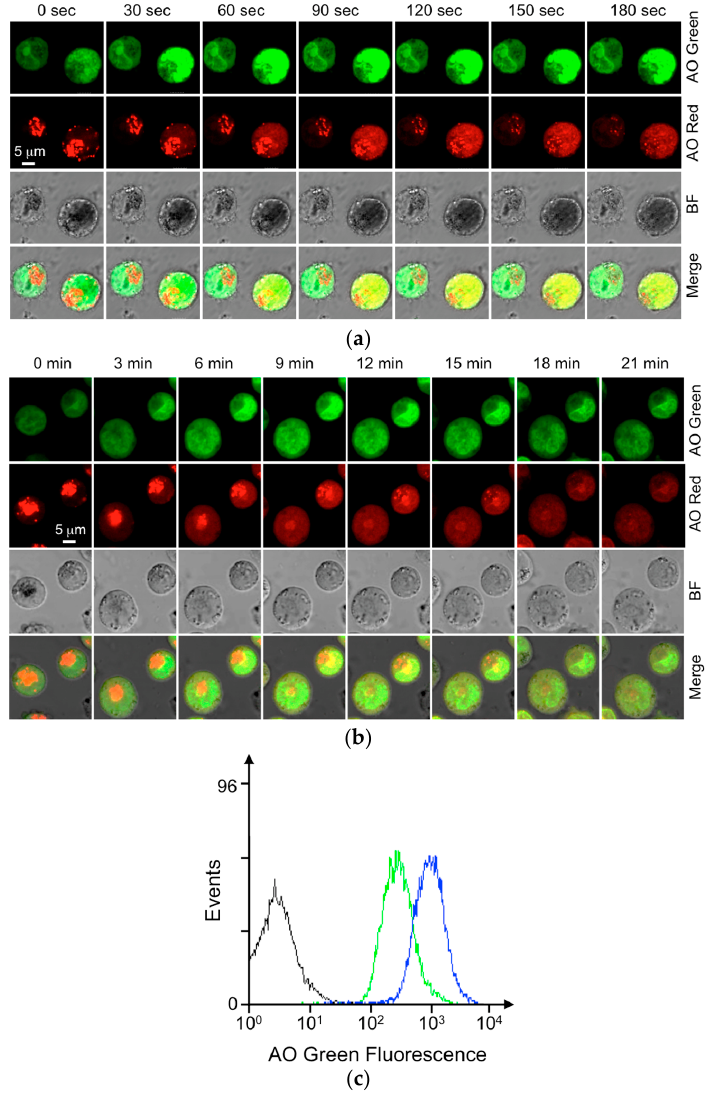
Figure 2. AO was released from the granules of live KU-812 cells by NH 4 Cl and ionomycin with PMA. KU-812 cells (1 × 10 6 /mL) were loaded with AO (0.5 µg/mL) overnight at 37 °C, 5% CO 2 . During incubation, AO was actively accumulated in the acidic granules. After loading, cells in suspension were placed in a confocal dish coated with polylysine. After stabilization, cells were activated with NH 4 Cl (10 mM) ( a ) or ionomycin (1.0 µM) with PMA (20 nM) ( b ) at time zero. Bright field (BF), AO red fluorescence, AO green fluorescence images were acquired from a confocal microscope at the time as indicated. Scale bar represents the cell dimension; after stimulation, AO released in the supernatant was transferred to another Eppendorff to label DNA in the chemically fixed HepG2 cells. Histograms from left to right ( x -axis in log scale): fixed HepG2 cells in PBS; fixed HepG2 with the supernatant from untreated KU-812 cells; fixed HepG2 with the supernatant from KU-812 cells treated with ionomycin (1.0 µM) and PMA (20 nM) for 20 min at 37 °C, 5% CO 2 ( c ).